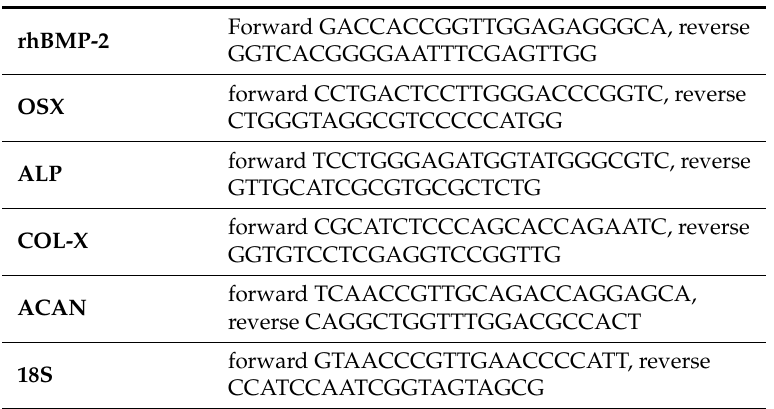
Table 1. Primers used to monitor osteogenesis and